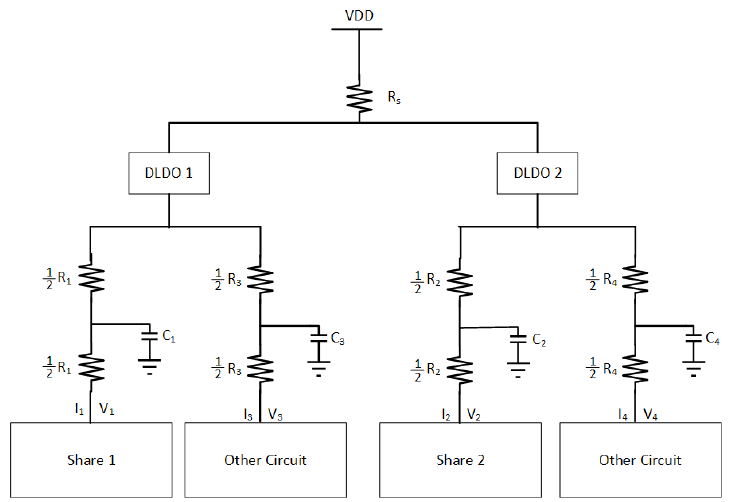
Figure 19. PDN for masking shares and other circuits when each masking share is connected to a dedicated DLDO voltage regulator. This type of connection makes the noise coupling from one share to another significantly more difficult.